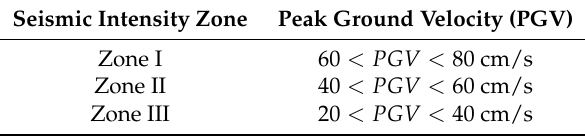
Table 4. Seismic zone intensity classification in the Earthquake Master Plan for Istanbul (EMPI)